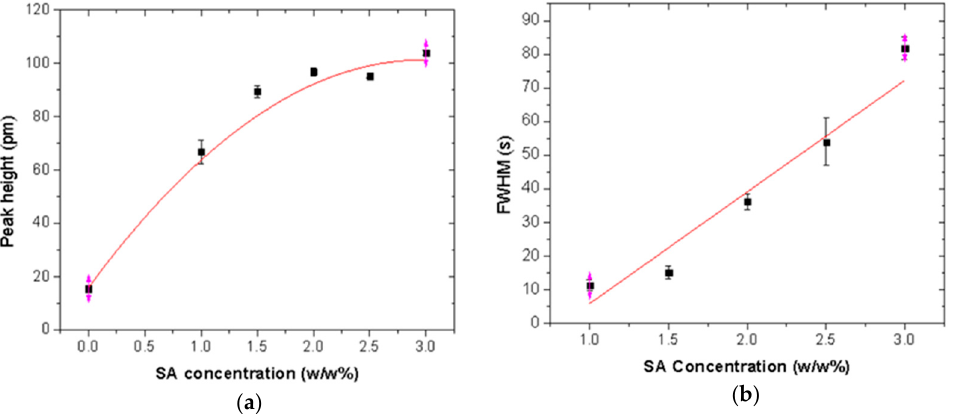
Figure 3. ( a ) Depiction of the peak height as SA w/w% increases; ( b ) Representation of the increase of FWHM of the peak while the SA w/w%